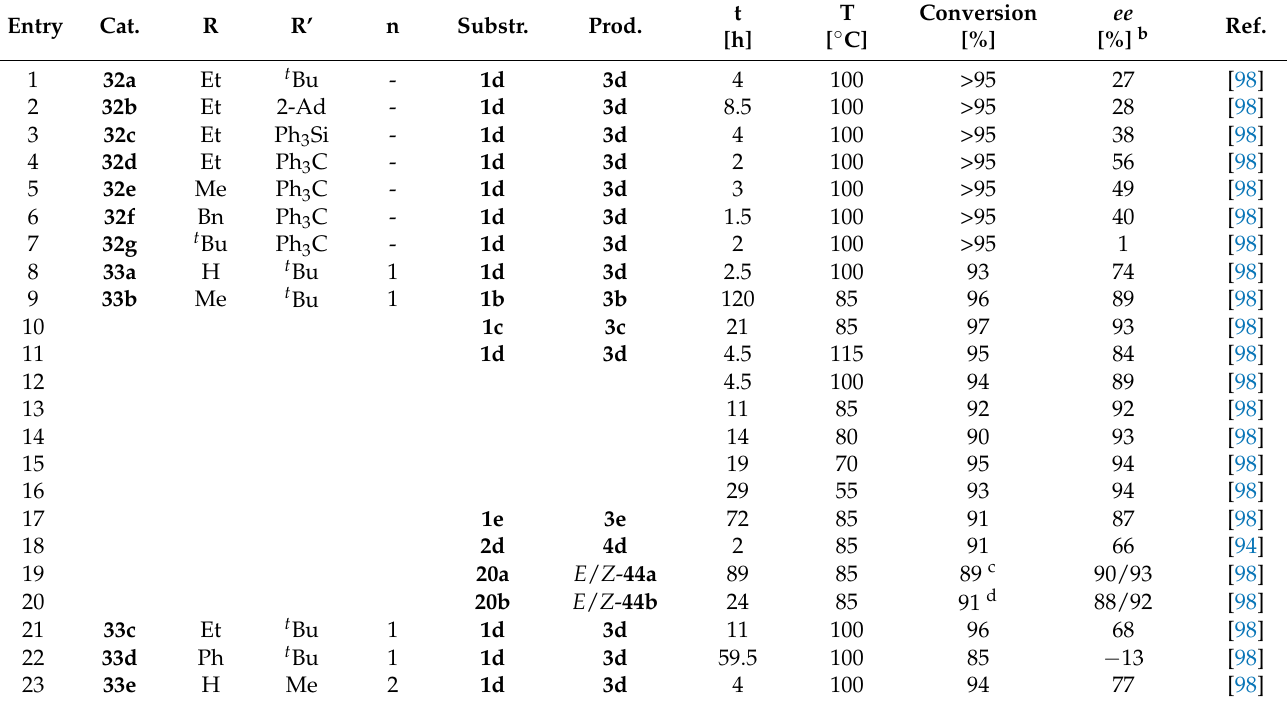
Table 12. Catalytic asymmetric hydroamination of 1b – e , 2d and 20a , b using chiral zirconium catalysts 32a – g and 33a – e a